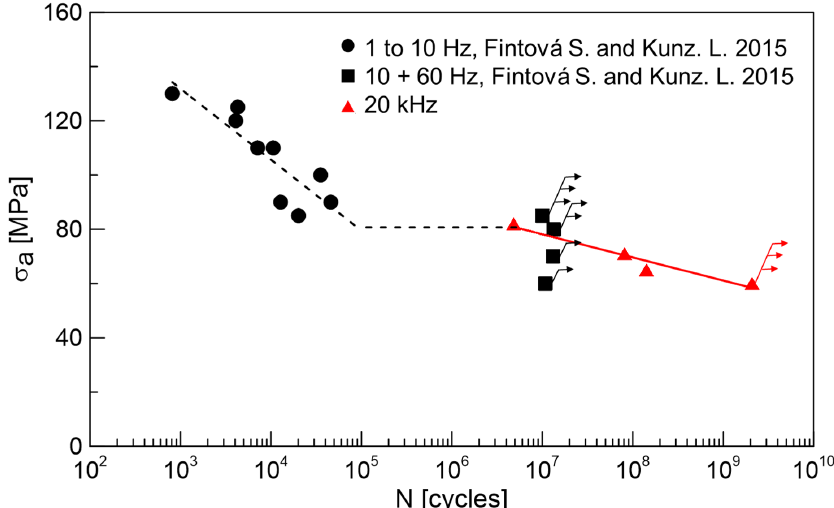
Figure 3. S ‐ N curves for cast AZ91 magnesium alloy. Arrows indicate the run ‐ out specimens, exceeding 1 × 10 7 or 2 × 10 9 cycles depending on the test conditions. Data of the tests performed up to 60 Hz (black symbols) were published by authors in [17].